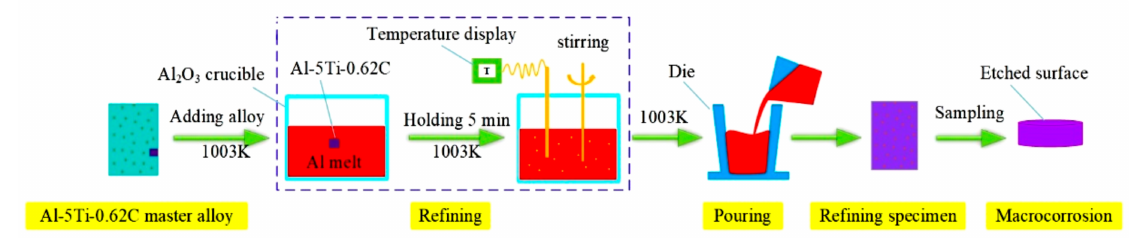
Figure 2. The experimental flow chart for refining commercial